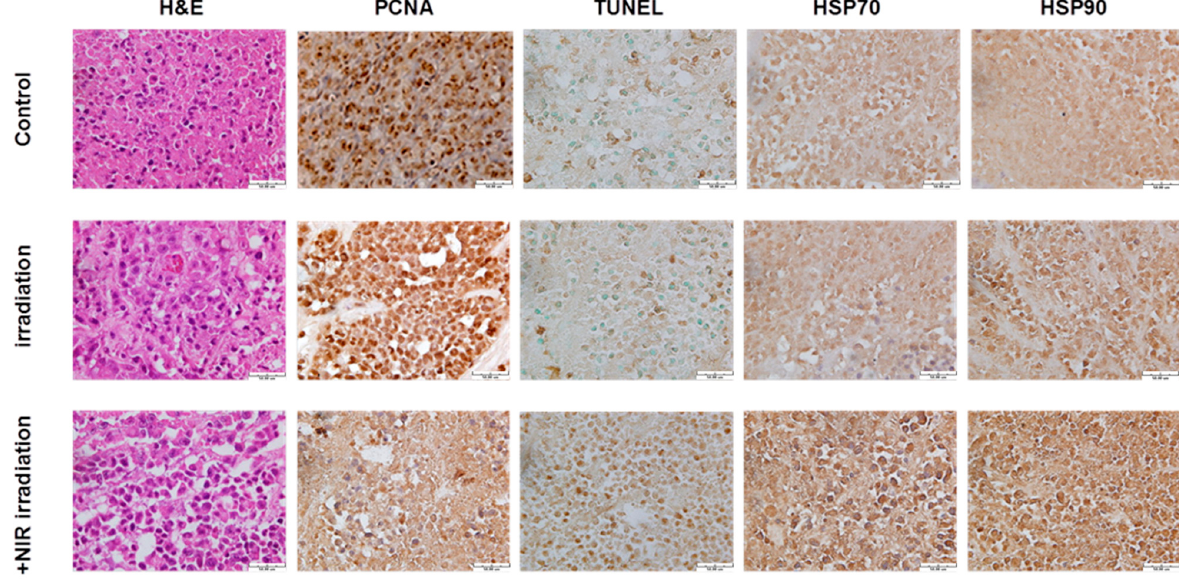
Figure 9. Histological and immunohistochemical analysis in 4T1 tumors treated with DOTA-NIR790-mediated photothermal therapy. The scale bar is 50 μ m.